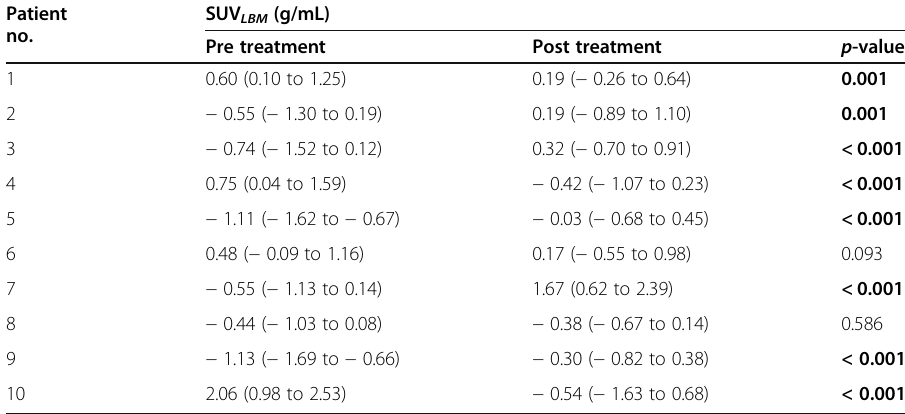
Table 3 Association between the relative mean difference (range), derived from reversibility Bull ’ s eye plots, in SUV LBM (g/mL) before and after BMC injection Patient SUV LBM no.